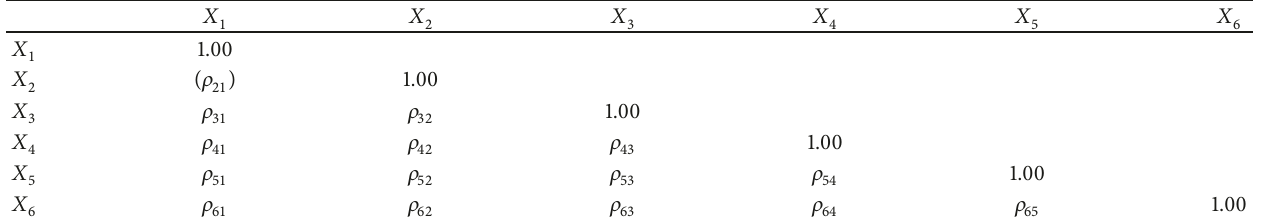
Table 2: The correlation coefficient